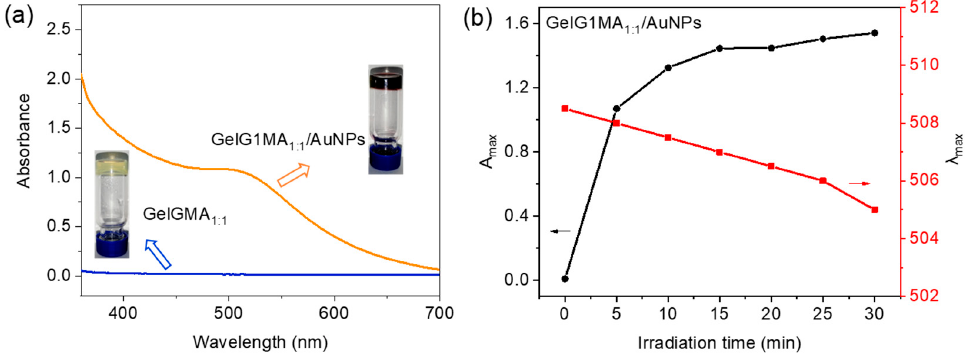
Figure 8. ( a ) UV/vis absorption spectra and photographs of GelG1MA 1:1 /AuNPs and GelG1MA 1:1 hydrogel after UV irradiation for 5 min. ( b ) Plots of A max and λ max of GelG1MA 1:1 /AuNPs hydrogel with UV irradiation time.